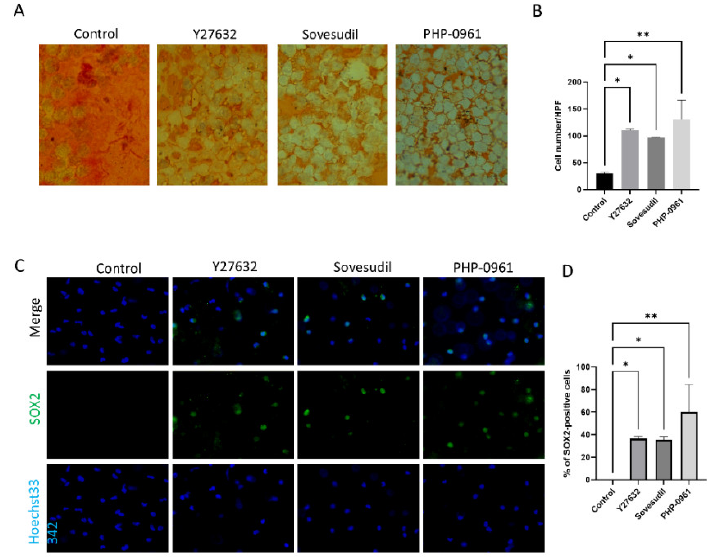
Figure 6. Effect of sovesudil on regeneration of corneal endothelium in a porcine ex vivo study. ( A , B ) Alizarin S red staining showed the faster wound healing in corneas with ROCK inhibitors. ( C , D ) SOX2 expression was evaluated by immunofluorescence staining of SOX2. * p < 0.05 and ** p <